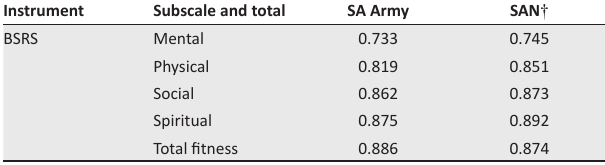
FIGURE 1: Brief Sailor Resiliency Scale factor TABLE 4: Brief Sailor Resiliency Scale reliability estimates – Cronbach’s alpha coefficients.